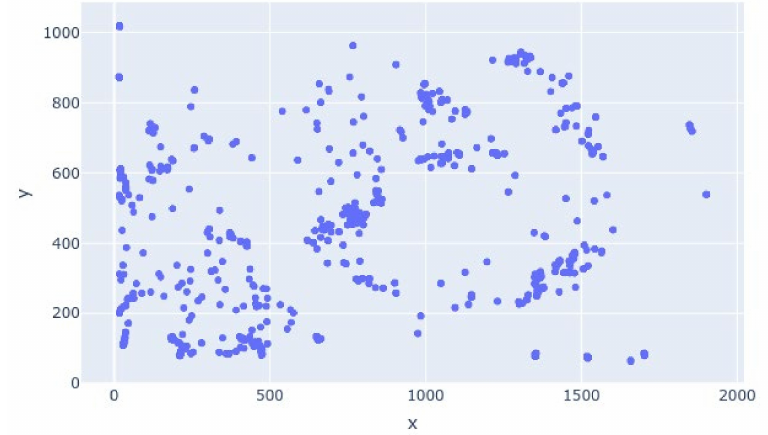
Figure 9. The scatter plot of the coordinates of detected human figures.